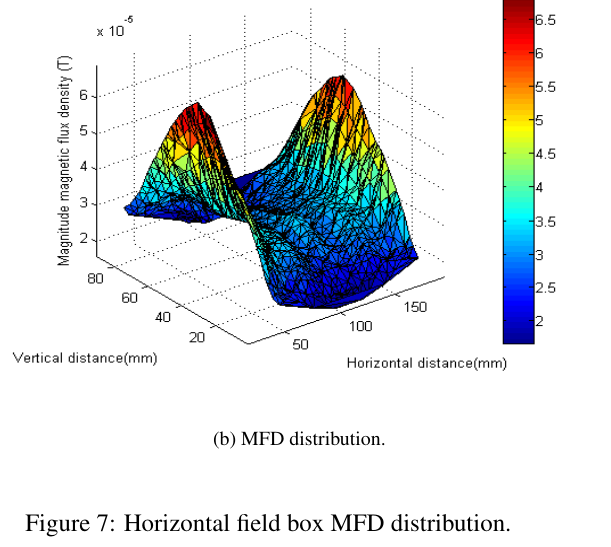
Figure 7: Horizontal field box MFD distribution.